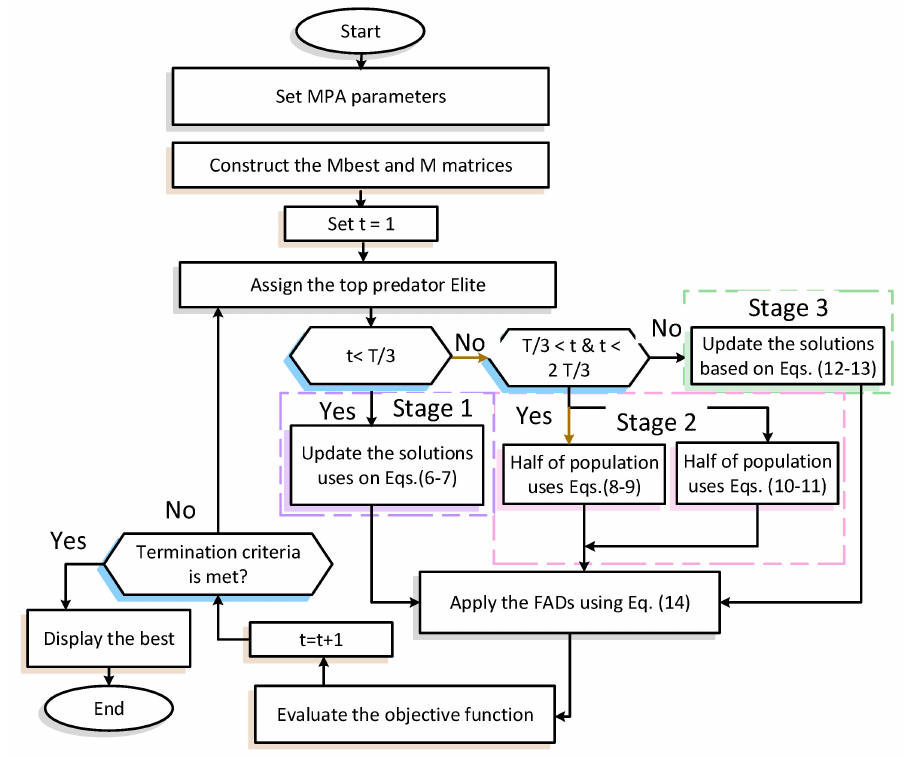
Figure 6. Flowchart of MPA